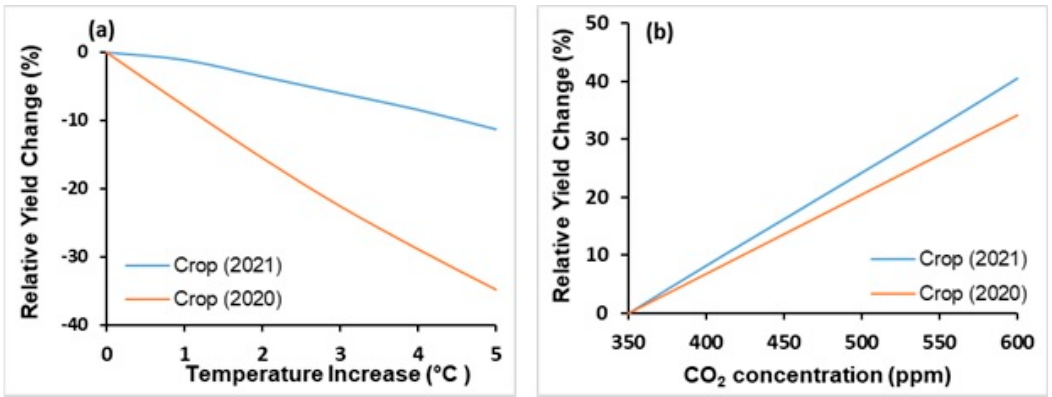
Figure 9. Simulated yields for soybean with ( a ) increasing temperature and ( b ) elevated atmospheric CO 2 concentration.